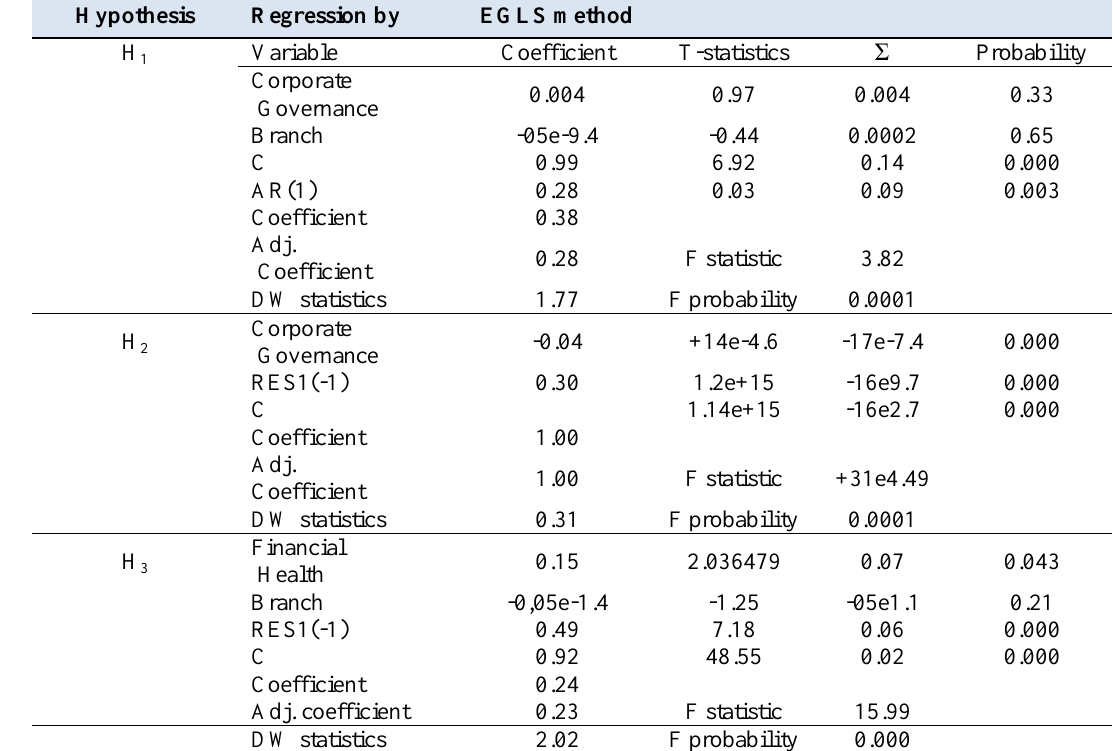
Table 7. Final estimate of the statistical model of